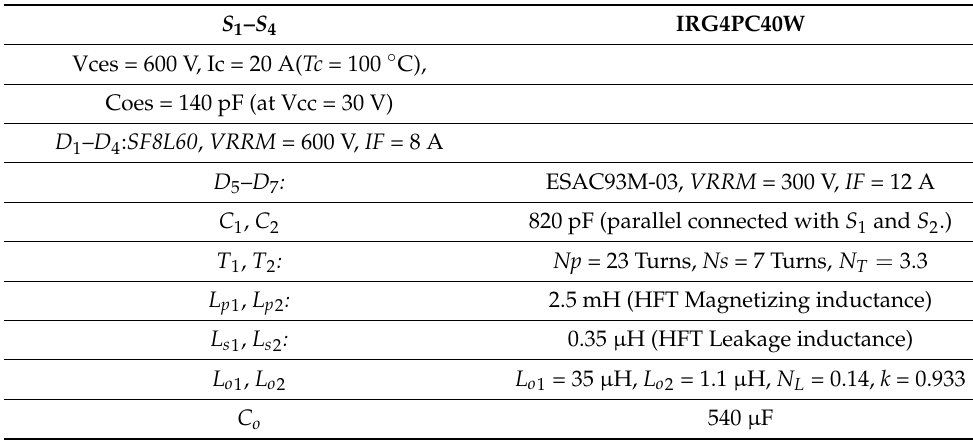
Table 1. Circuit parameters of prototype